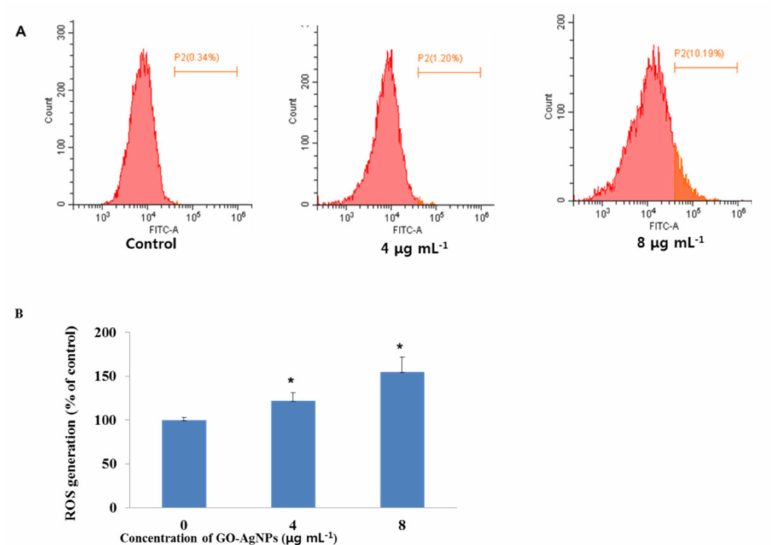
Figure 4. Total reactive oxygen species (ROS) generation in GO-AgNP-treated cells. Caprine fetal fibroblast cells (CFFCs) were treated with 0, 4, and 8 µ g/mL of GO-AgNPs for 24 h and analyzed by FACS ( A ). The percentage of ROS generation relative to the untreated control group (0 µ g/mL) ( B ). Values are presented as the mean ± SD of four independent experiments (* p < 0.05).